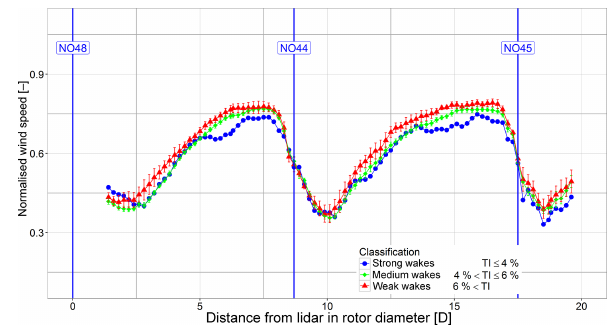
Figure 10. Wind speed recovery at wake centre at hub height be- hind NO48 for different turbulence stability classes. The wind speed is normalised with the inflow wind speed and the distance from the lidar on NO48 downstream is displayed in multiples of rotor diam- eters.